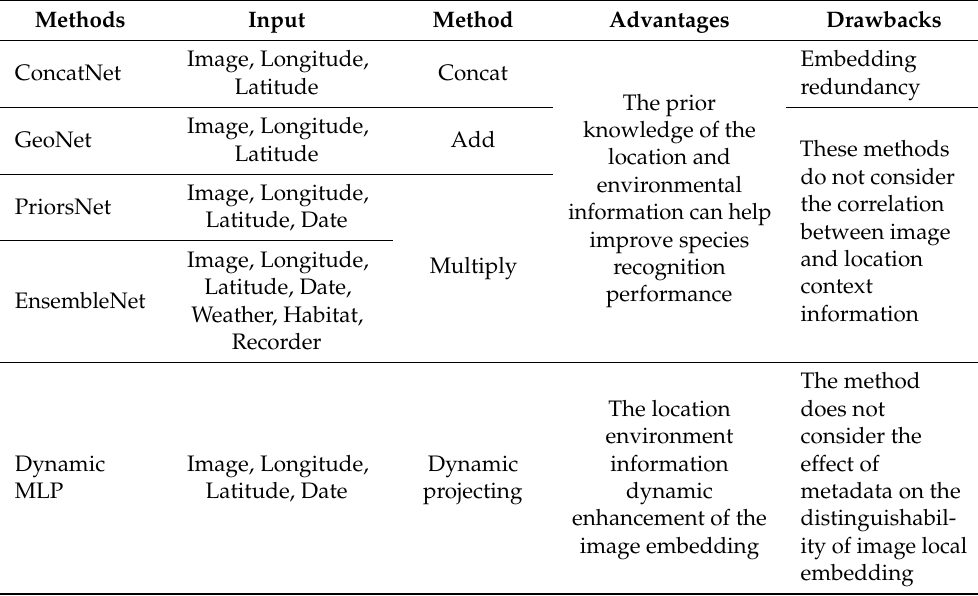
Table 1. The summary of multimodal fusion methods for species